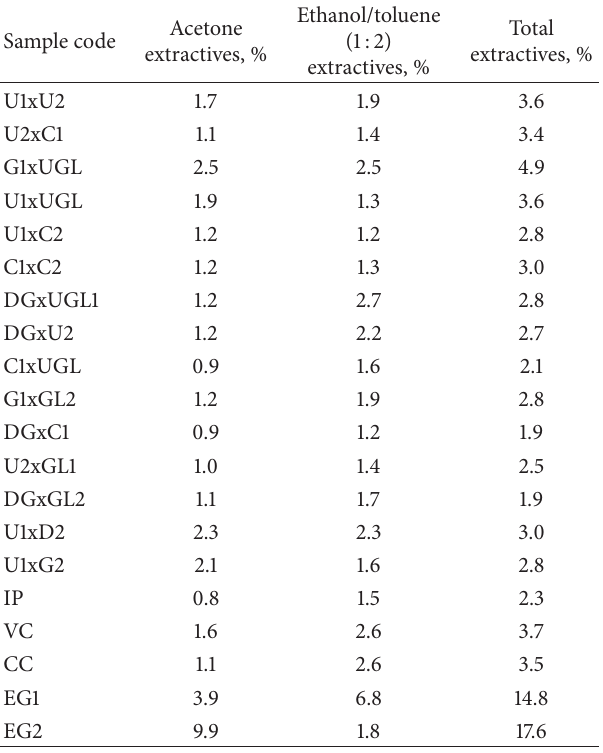
Table4:Extractivecontentoftheeucalyptclonesandelephantgrass species